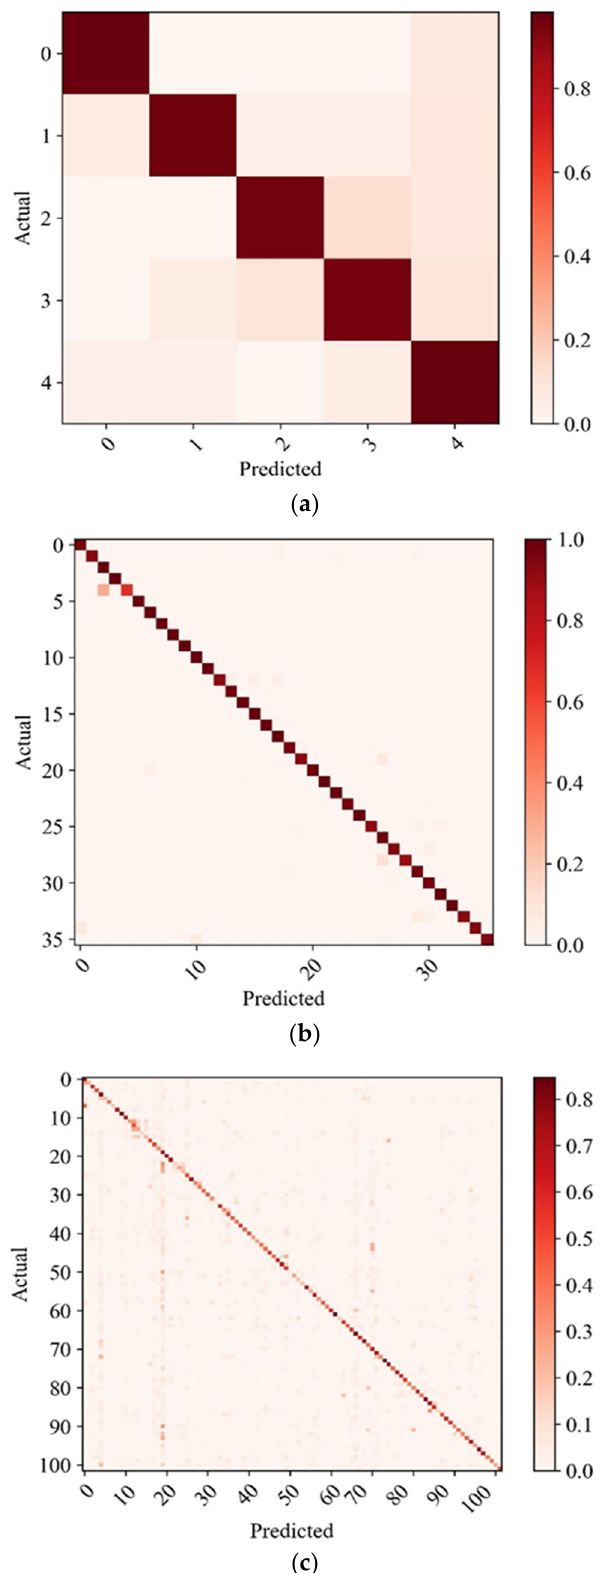
Figure 8. Confusion matrix: ( a ) Cassava; ( b ) AI Challenger; ( c ) IP102.